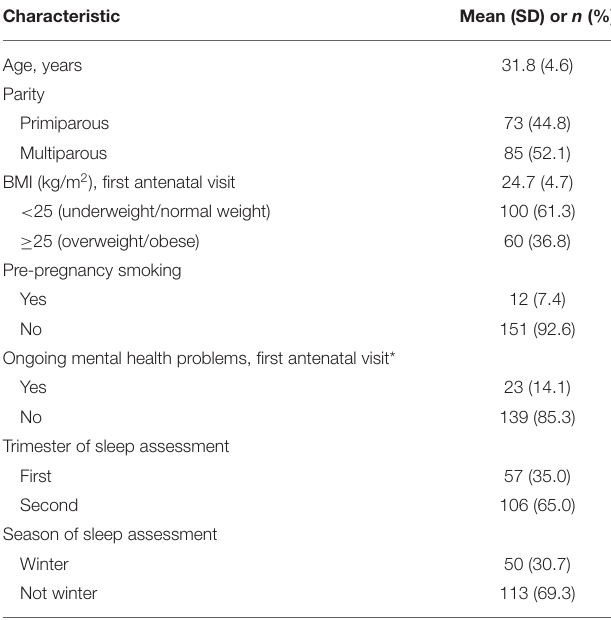
TABLE 1 | Participant characteristics ( n =